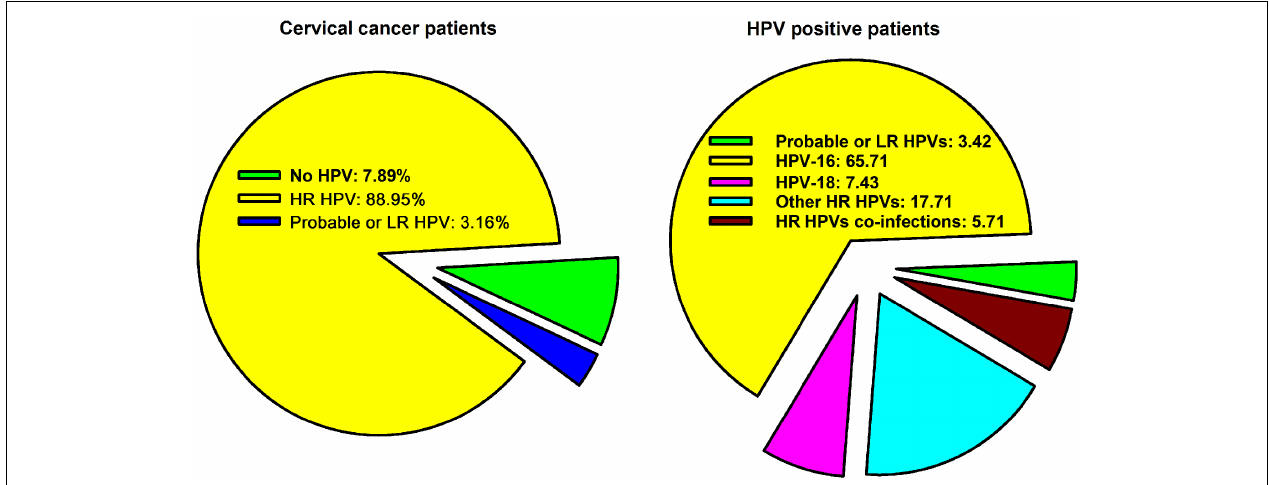
FIGURE 1 |The prevalence of HPV infection and genotypes distribution in cervical cancer in SaudiArabia compiled from two published studies (26,27) .